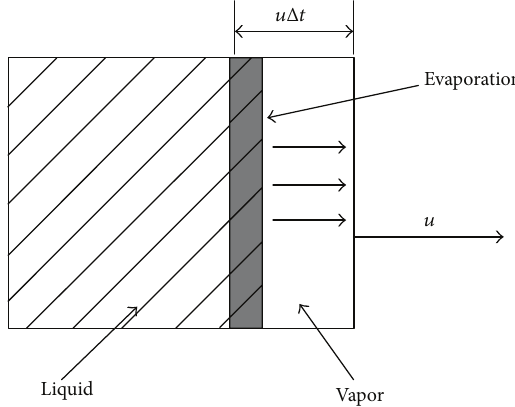
Figure 1: A typical mixture cell and the configuration of interfacial